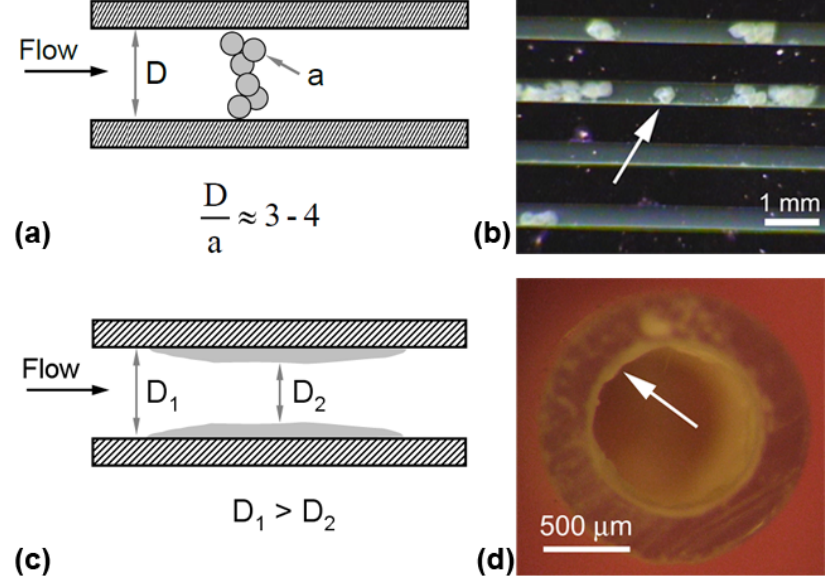
Figure 2b for NaCl formation, is imminent when St > 1, η > − 1, and ω > 1. Under such conditions particles traveling near the reactor wall deposit, forming dendrites that eventually bridge. Figure 2. Example plugging mechanisms that occur in micro-scale laminar